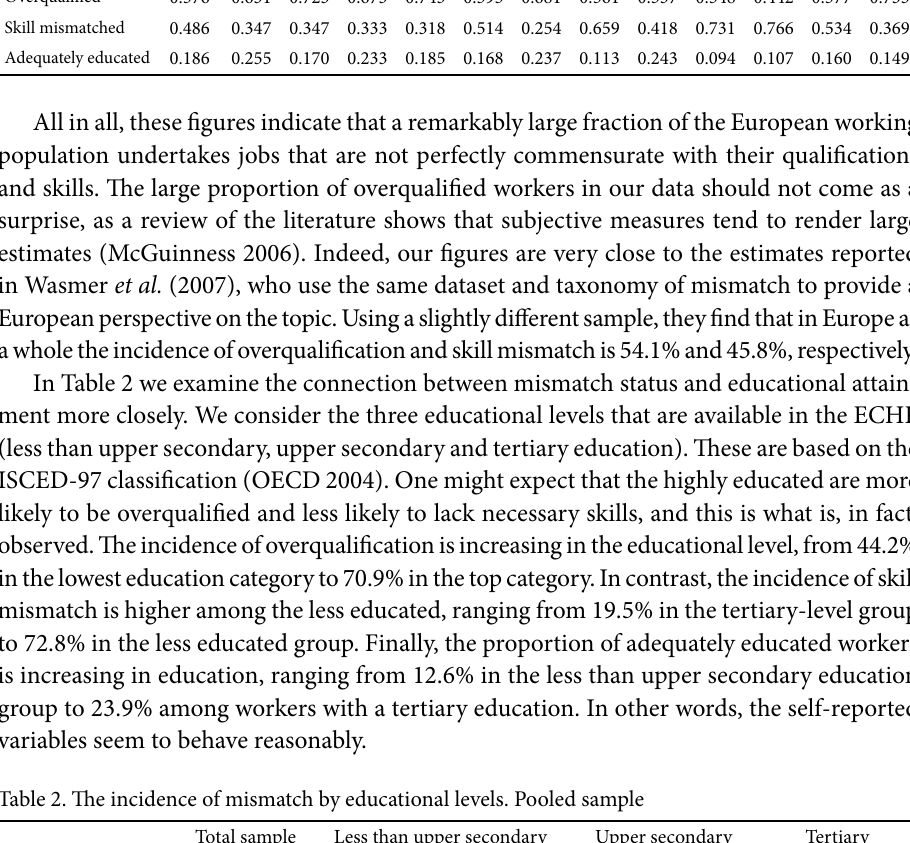
Table 1. The incidence of overqualification and skill mismatches by country Overqualified